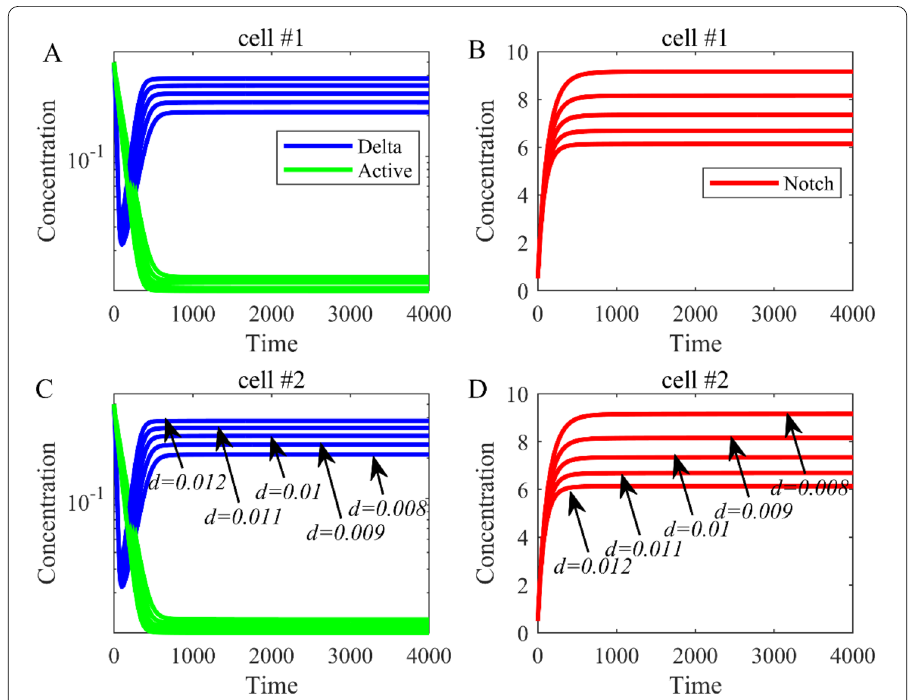
Figure 5 The sensitivity test of d from 0.008 to 0.012. ( A ) The dynamical trend of Delta and active Notch in cell 1. ( B ) The dynamical trend of Notch in cell 1. ( C ) The dynamical trend of Delta and active Notch in cell 2. ( D ) The dynamical trend of Notch in cell